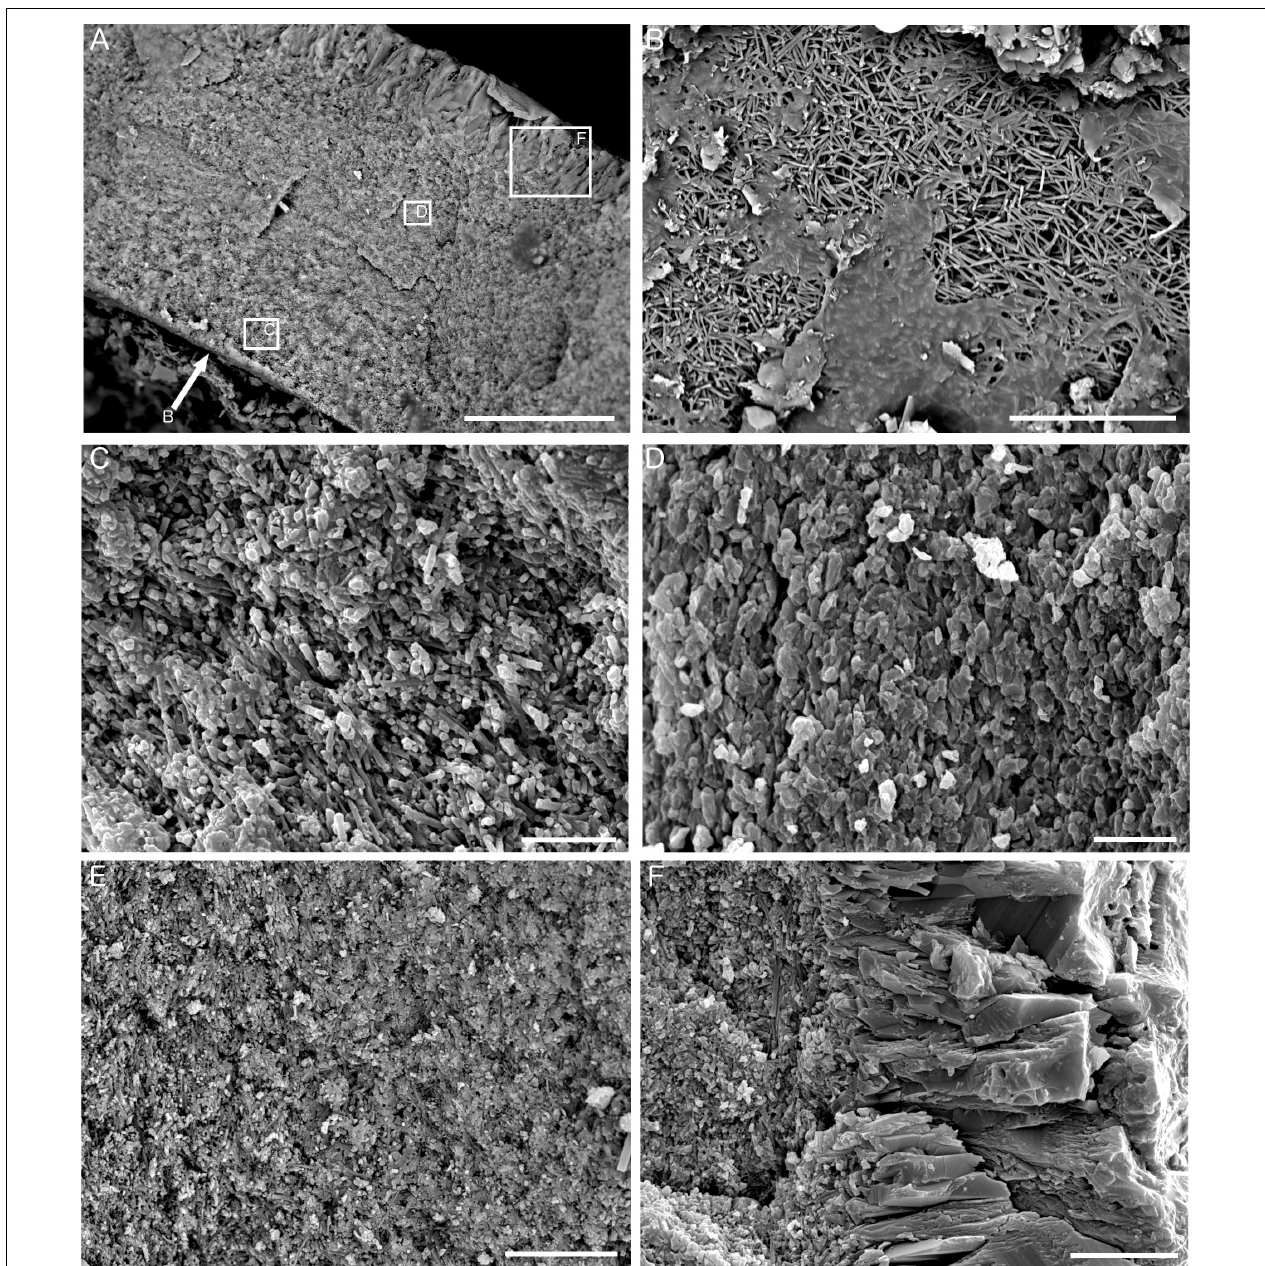
FIGURE 8 | Ultrastructure of Fossil Hill tubes. (A) Transverse section of a tube showing fine-grained inner layer and coarse-grained outer layer, sample DR476 A-1, and scale bar is 50 µ m. Arrow shows perspective of B , and boxes show representative locations for the textures pictured in C , D , and F . (B) View looking down onto the inner tube surface showing irregularly oriented prismatic (IOP) ultrastructure comprised of crystallites approximately 5 µ m in length, sample DR626 R-4, and scale bar is 20 µ m. (C) Detail of inner tube layer in transverse section showing IOP ultrastructure with homogeneous cement, sample DR626 R-4, and scale bar is 10 µ m. (D) Detail of outer part of fine-grained tube layer showing a grainy appearance, sample DR626 R-4, and scale bar is 5 µ m. (E) Fine-grained inner tube layer in transverse section showing a transition from a prismatic structure to a grainy/platy structure from left to right, sample DR629 BB, and scale bar is 15 µ m. (F) Detail of outer coarse-grained tube layer showing spherulitic prismatic (SPHP) ultrastructure, sample DR626 R-4, and scale bar is 10 µ